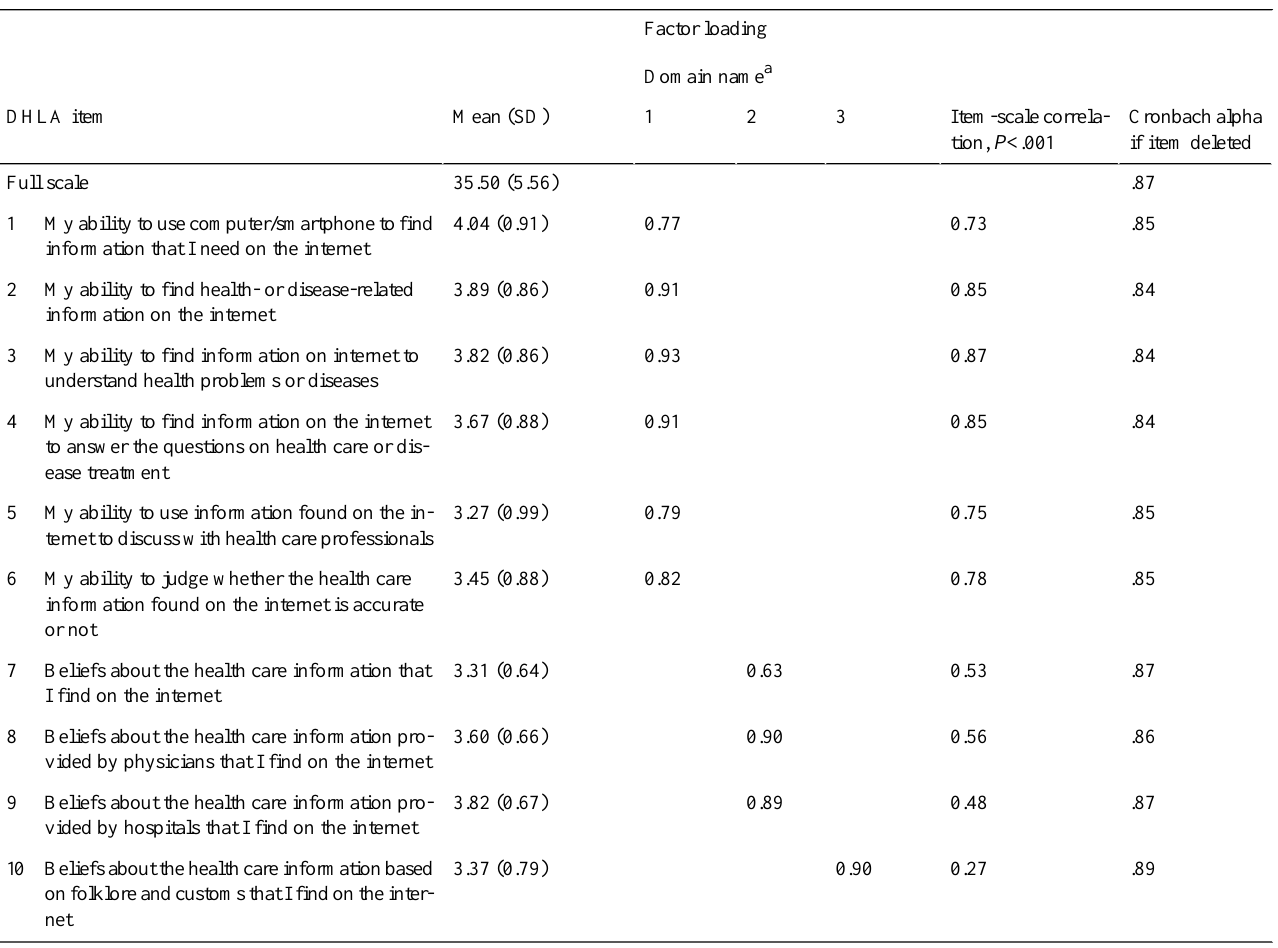
Table 1. Digital health literacy assessment (DHLA) internal reliability and factor structure.